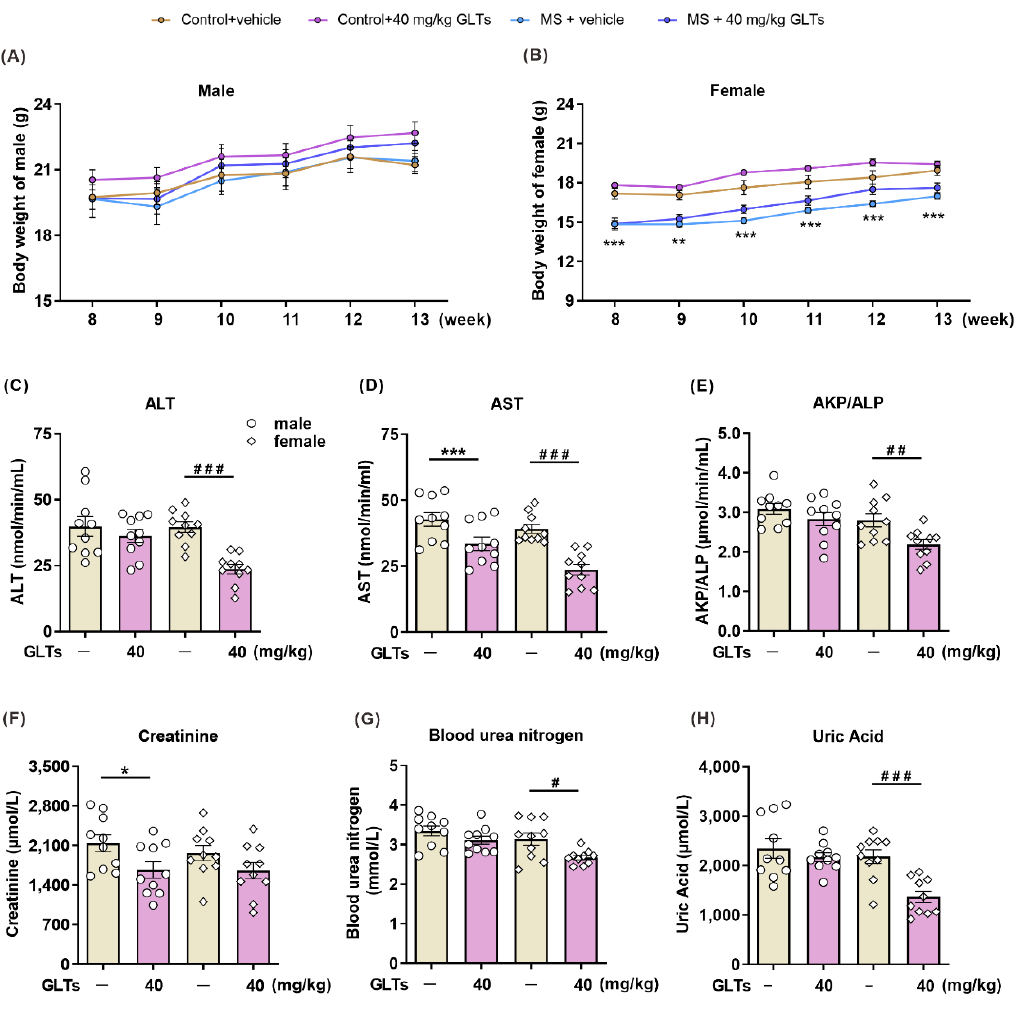
Figure 6. No adverse effects of GLTs on body weight and the functions of liver and kidneys. ( A , B ) Body weight of male ( A ) and female ( B ) mice from 8th week to 13th week. Data are expressed as mean ± SEM, n = 11-13/group. ** p < 0.01 *** p < 0.001, as compared with female Control + vehicle group. ( C – E ) The level of liver damage biomarkers ALT ( C ), AST ( D ), and AKP/ALP ( E ) in the plasma of male and female mice. ( F – H ) The level of kidney damage biomarkers creatinine ( F ), blood urea nitrogen ( G ), and uric acid ( H ) in plasma of male and female mice. Data are expressed as mean ± SEM, n = 10/group. * p < 0.05, *** p < 0.001, as compared with male Control + vehicle group; # p < 0.05, ## p < 0.01, ### p < 0.001, as compared with female Control + vehicle group.